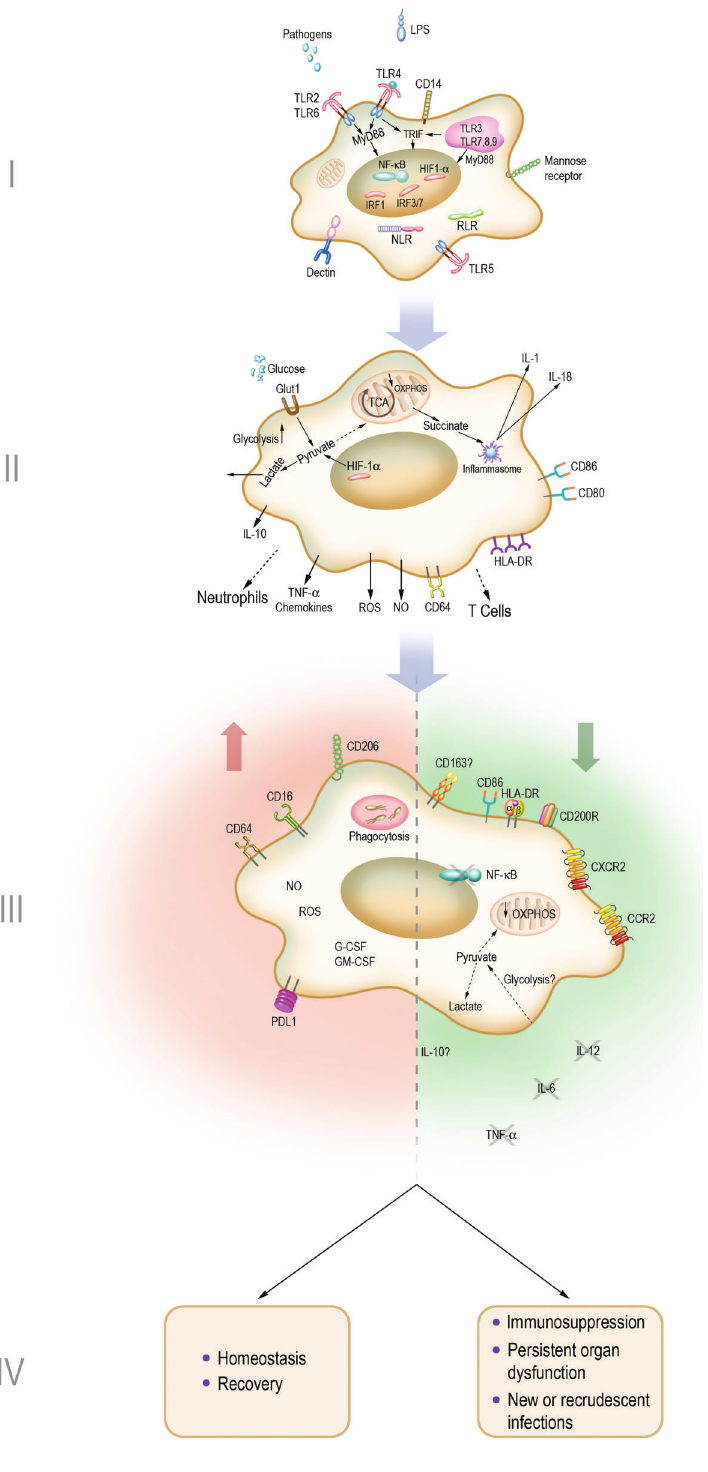
Figure 3. Modulation of monocytes/macrophages response during sepsis. I , In the initial infectious process, microorganisms and their products (pathogen-associated molecular patterns, such as lipopolysaccharide) are recognized by innate immune cells, such as macrophages through pattern recognition receptors, triggering intracel- lular in fl ammatory response pathways. II , Ampli fi - cation of the in fl ammatory and immune response occurs through the synthesis of in fl ammatory mediators and cell-to-cell contact. Activated macro- phages use glycolysis as a source of energy and biosynthetic intermediates to carry out its effectors ’ functions. III , Monocytes/macrophages reduce the production of in fl ammatory cytokines and the ef fi ciency of T cell activation, while they retain the ability to phagocytose and kill microorganisms through the generation of ROS and nitric oxide (NO). IV , Resolution or immunosuppression. This phase represents the return to homeostasis and clinical recovery or, in a complicated course, the lack of an in fl ammatory response leads to immu- nosuppression, persistence of organ dysfunction, and emergence of new or recrudescent infections. Panel I adapted from (12) with permission. Promo- tional and commercial use of the material in print, digital or mobile device format is prohibited without the permission from the publisher Wolters Kluwer. Please contact permissions@lww.com for further